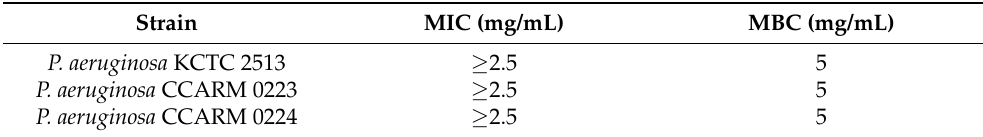
Table 3. The minimum inhibitory concentration (MIC) and minimal bactericidal concentration (MBC) of CFSs of P. inopinatus K35.